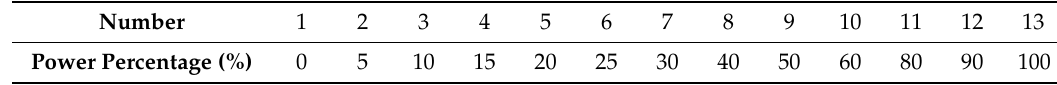
Table 1. Main diesel engine condition recorded in the experiment.